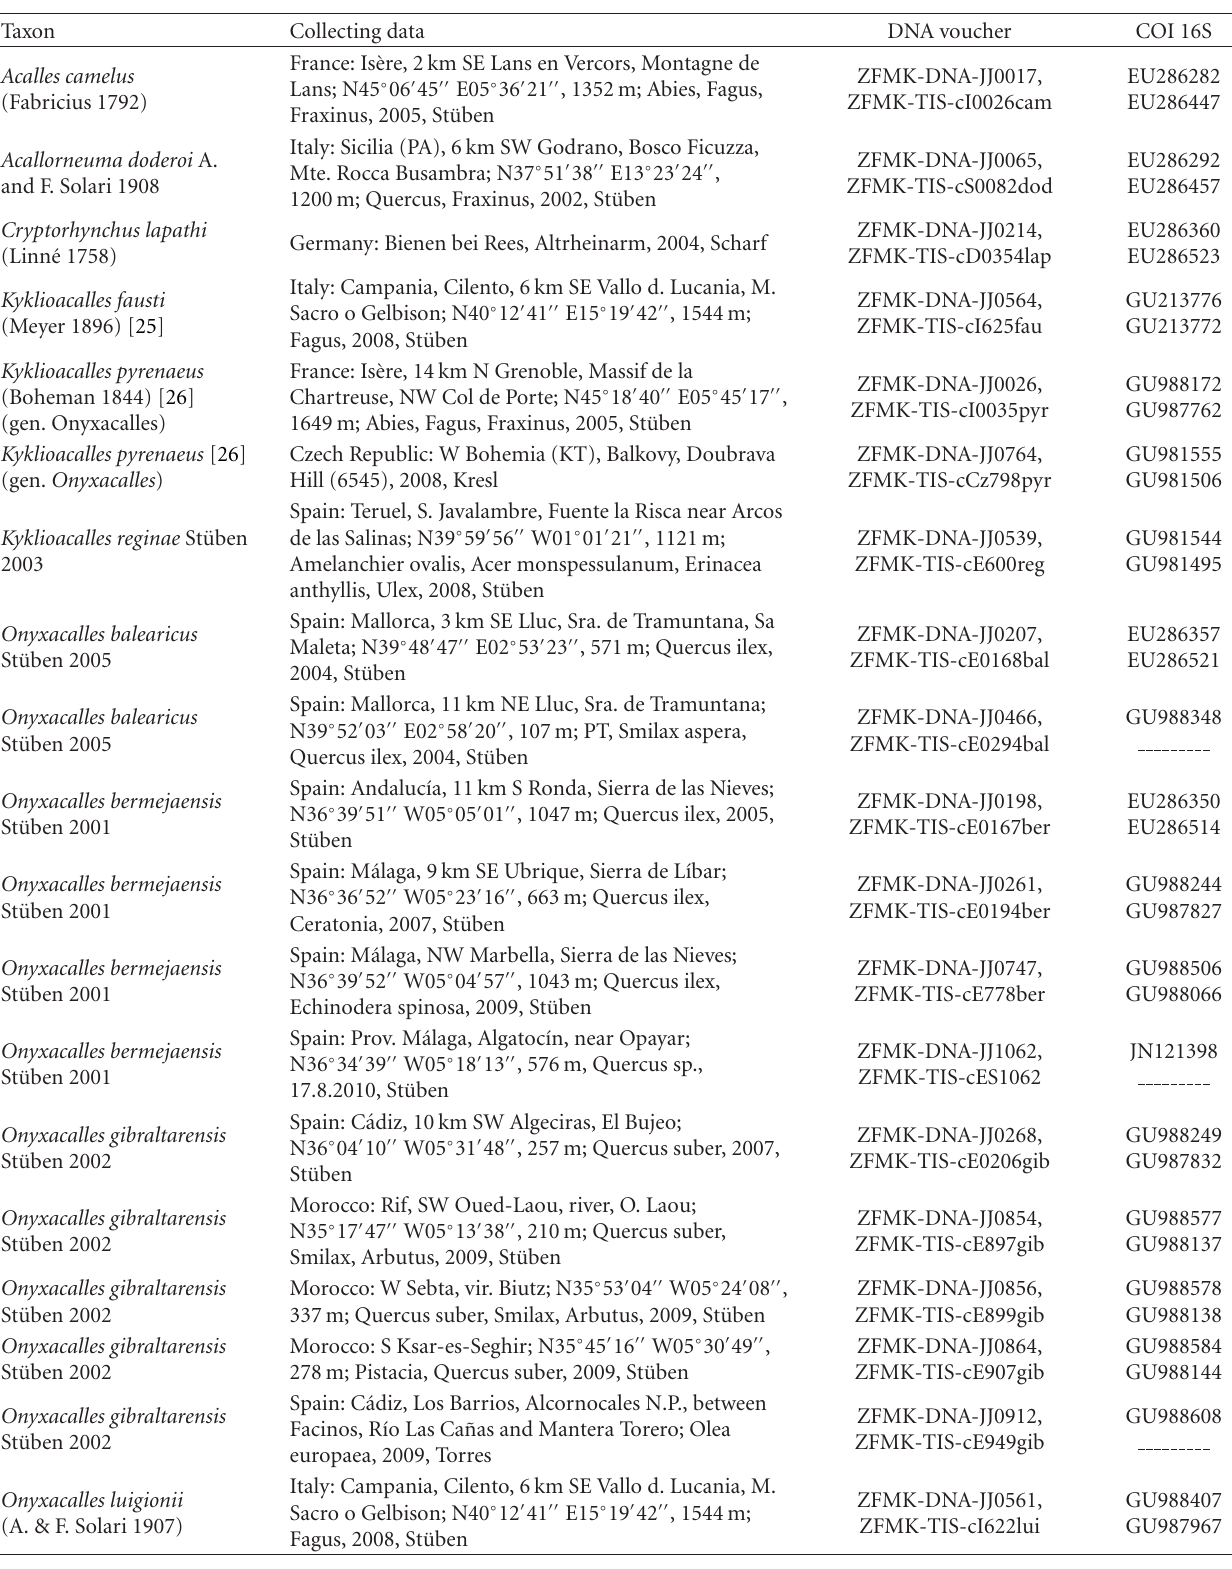
Table 1: Collecting data, vouchers, and GenBank accession numbers for the material analysed in this study. All specimens determined by P. E. St¨uben, 2010 and 2011. Vouchers (DNA, morphology) are kept at the ZFMK Biobank. Most sequences have been published (or are reviewed) in Astrin et al. 2012 [21]. GenBank accession numbers of new sequences in this study start with “JN ... ”. Taxonomic changes with regard to this publication are printed in brackets (old